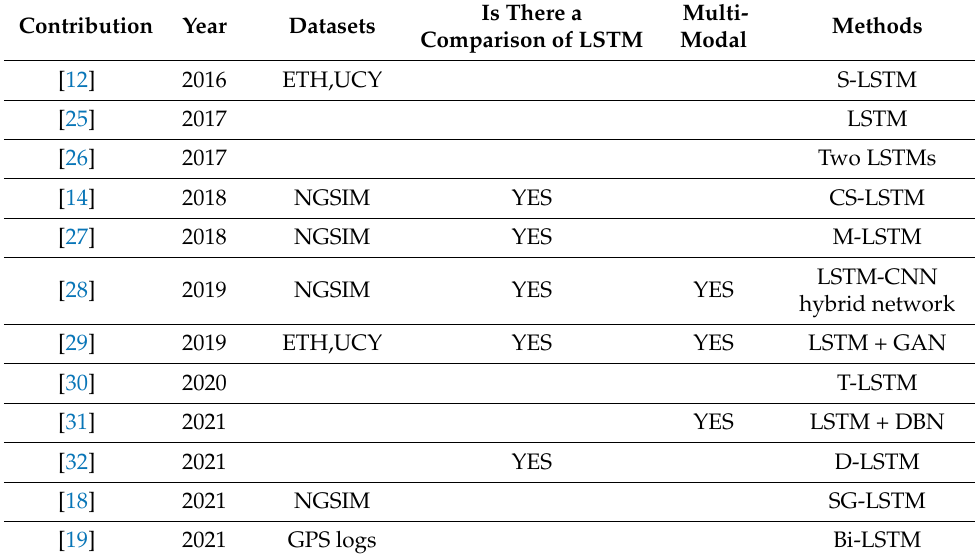
Table 1. Information table about LSTM in previous